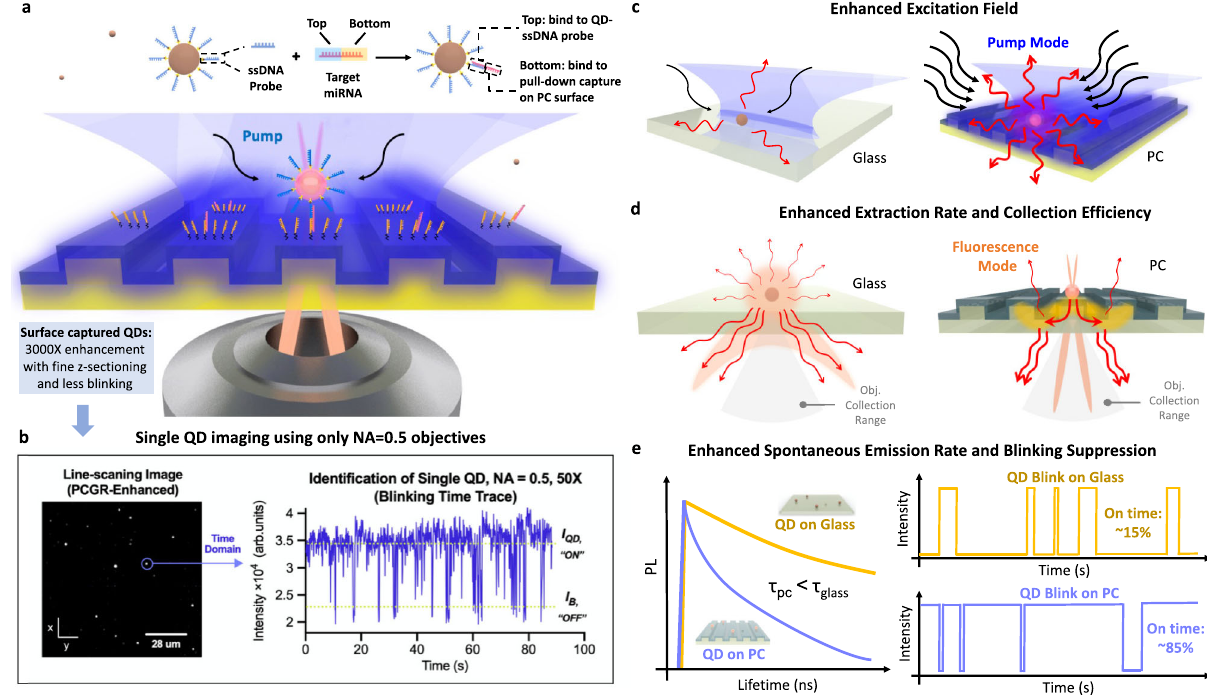
Fig.1|PCenhancedQDemissionenablessingleQDdigitalcountingresolution forsingletargetmiRNAdetection.a SchematicofthebridgeassaydesignandPC- QD resonance-enhanced miR digital counting detection approach utilizing 3000× fl uorescence enhancement with fi ne z -sectioning and blinking suppression. Com- ponents of the PC-QD-enhanced miRNA digital diagnostics are shown in the top part, wheressDNAprobe (blue)isfunctionalized onaQD-streptavidinsurfacewith ~10:1 ratio. Basedon NUPACK simulation, the length of the capturestrand (yellow) is set to 10bases (pair with the bottom part of the target) while the probe length is 12 bases (pair with the top part of the target), for a total of 22 bases of com- plementary pairs for double hybridization with target miRNA 375 (pink). In the bridge-activatedassayprocess,QD-tagswillbepulleddowntothePCsurfacewhen targetmiRNAsformasurface-bound complex. b Surface-capturedQDsexperience 3000× enhancement compared to the free- fl oating uncaptured QDs. The strong enhancement factor enables single QD imaging using only NA=0.5 objective lens.